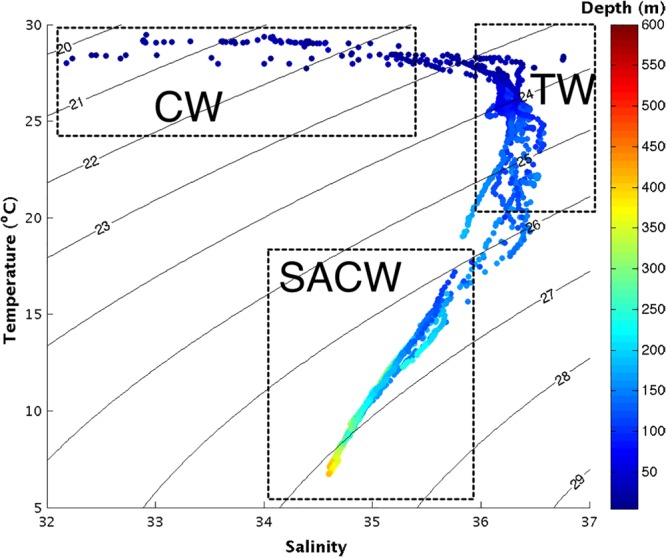
T-S diagram with pairs of temperature and salinity for the whole studied area in September 2014. The colors represent the depth (in meters) at which the pairs of temperature and salinity were obtained. The dashed rectangles identify the water masses. CW, Coastal Water; TW, Tropical Water; SACW, South Atlantic Central Water.